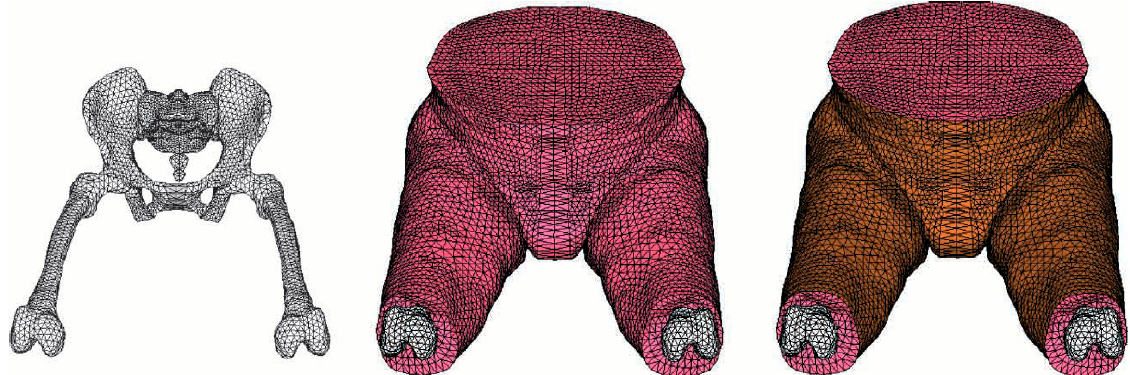
Figure 4. Thigh and buttocks section of a human FE model. Left: Bony structure, Middle: Bony Structure and Human Soft tissue; Right: Full human model with bony structures, soft tissues, and skin [44].